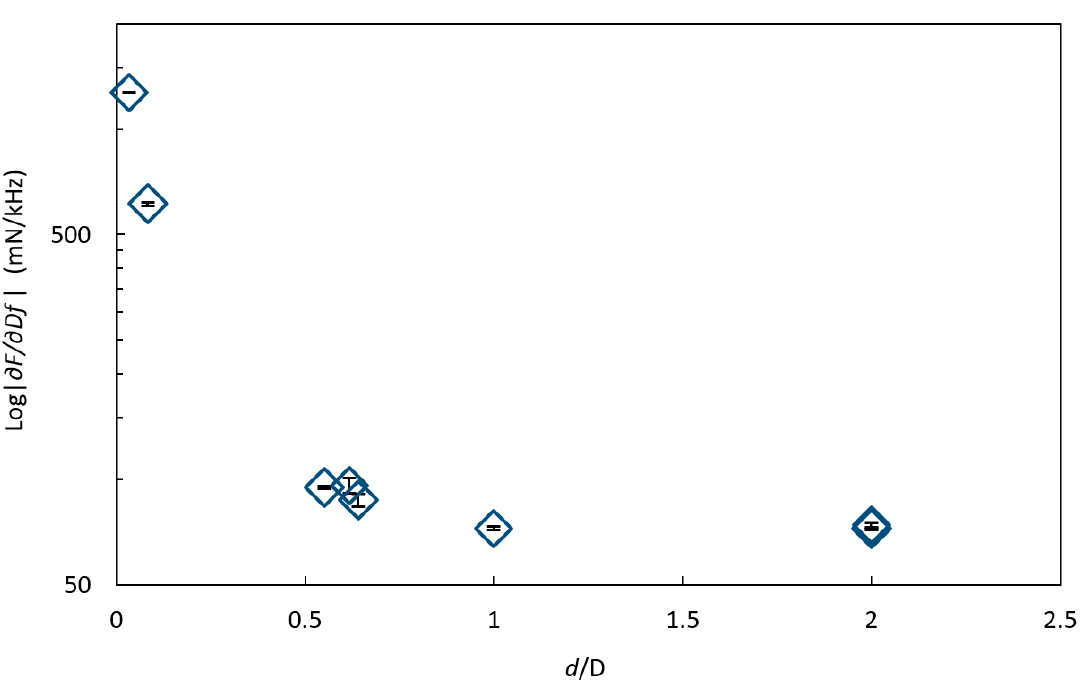
Figure 7. The logarithm of the stiffness parameter log | ∂ F / ∂ ∆ f | (mean ± SD, n = 6) against the ratio between the depths d of the inclusion and the diameter D of the inclusion, d / D , at α sm = 0 ◦ on inclusions of different sizes and at different depths in a silicon sphere showing that the inclusions could be detected up to about d/D = 0.6. The standard deviations are included in the graph.